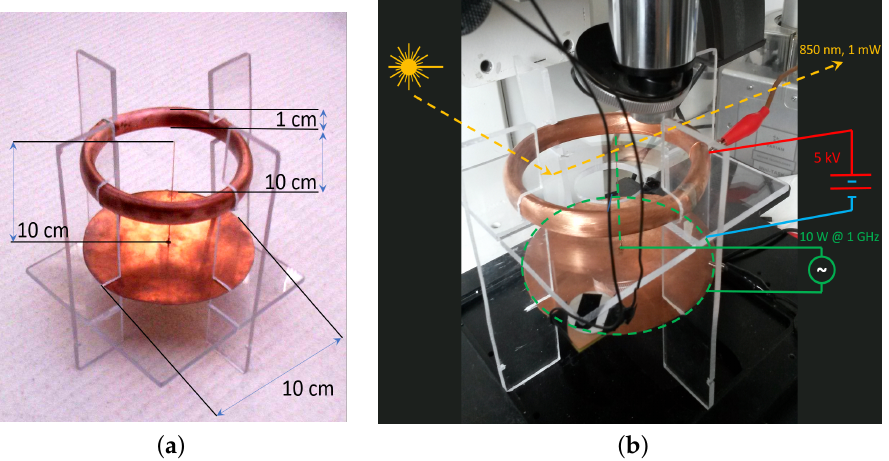
Figure 11. The structure of the device tested in 2014 is shown in ( a ), with quotes reported in cm. The same device under test is shown in ( b ). The labelling describes how the measurement was conducted. The acrylate transparent stand was used to keep the ring and RF antenna in position on the one side, and to provide a stable horizontal surface where the cantilever is positioned, to explore the pressure effects. The yellow arrows represent the laser beam (1 mW @ 850 nm) directed to the cantilever and reflected toward the four-quadrant photodetector. Red and blue lines represent the high-voltage (5 kV) connection scheme (the ring on the one side, the copper dish on the other), whereas green lines represent the RF (10 W @ 1 GHz) connection scheme (the central copper wire and the dish). A silicon cantilevered chip was positioned at the reflection point of the laser beam, centered using the microscope objective visible at the top of Figure 11b . The piezoelectric actuator that triggers the oscillation of the silicon cantilever was located on the front of the picture, fixed to the horizontal acrylate plate. The power was supplied via two black wires vertically aligned and running through the experiment volume from the microscope objective to the plate. The signal to power the piezodrive, locked to the four-quadrant sensor output, had an amplitude of 10 V and a frequency between 20 Hz and 50